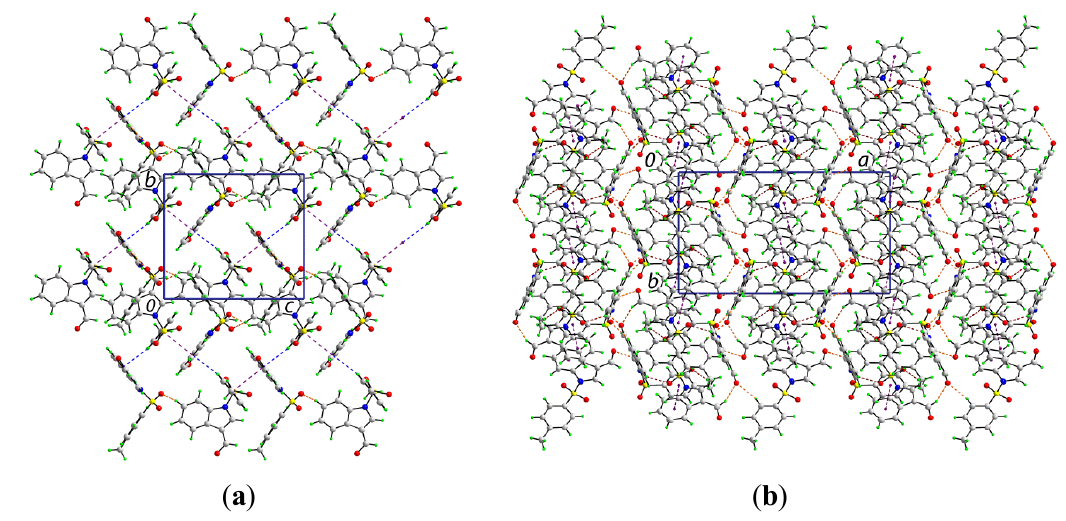
Figure 3. Views of the supramolecular association in the crystal structure of 1 : ( a ) supramolecular layer in the bc -plane, and ( b ) in projection down the c-axis showing the stacking of layers along the a -axis. The  ···  , C-H···O (within layers), C-H···O (between layers), and C-H···  interactions (obscured in the ( b ) projection) are shown as purple, brown, orange and blue dashed lines, respectively.